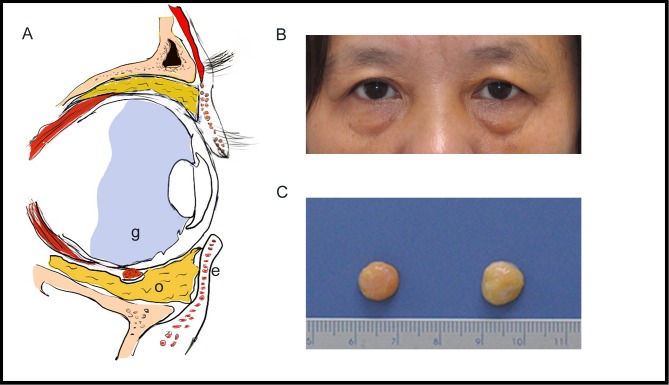
OF anatomy and observation.(A) Sagittal section of the human orbit showing OF location in the lower eyelid (e: lower eyelid skin and orbicularis oculi muscle; o: orbital fat; g: globe). (B) Photograph of a 56-year-old woman having baggy lower eyelids (who has given written informed consent to publish her picture in this manuscript). (C) Gross observation of OF tissue removed in lower eyelid blepharoplasty. The fat from young donor (right) appeared more yellow in color than that from the aged donor (left) (scale bar: 1mm).